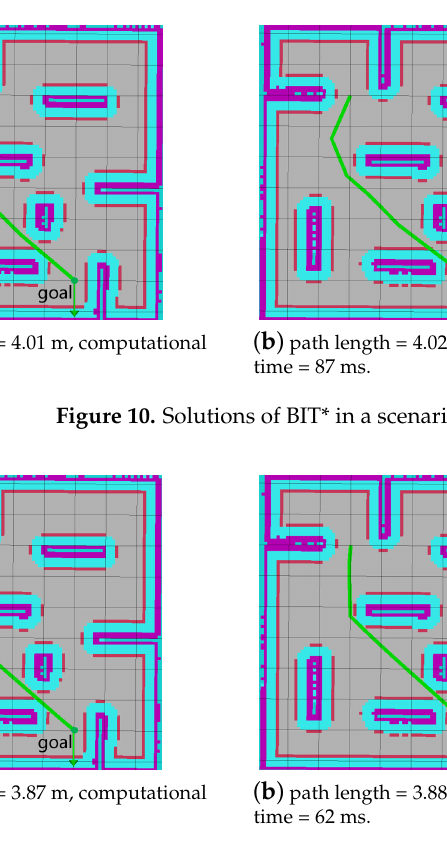
Figure 11. Solutions of modified BIT* in a scenario with multiple obstacles, 800 iterations.